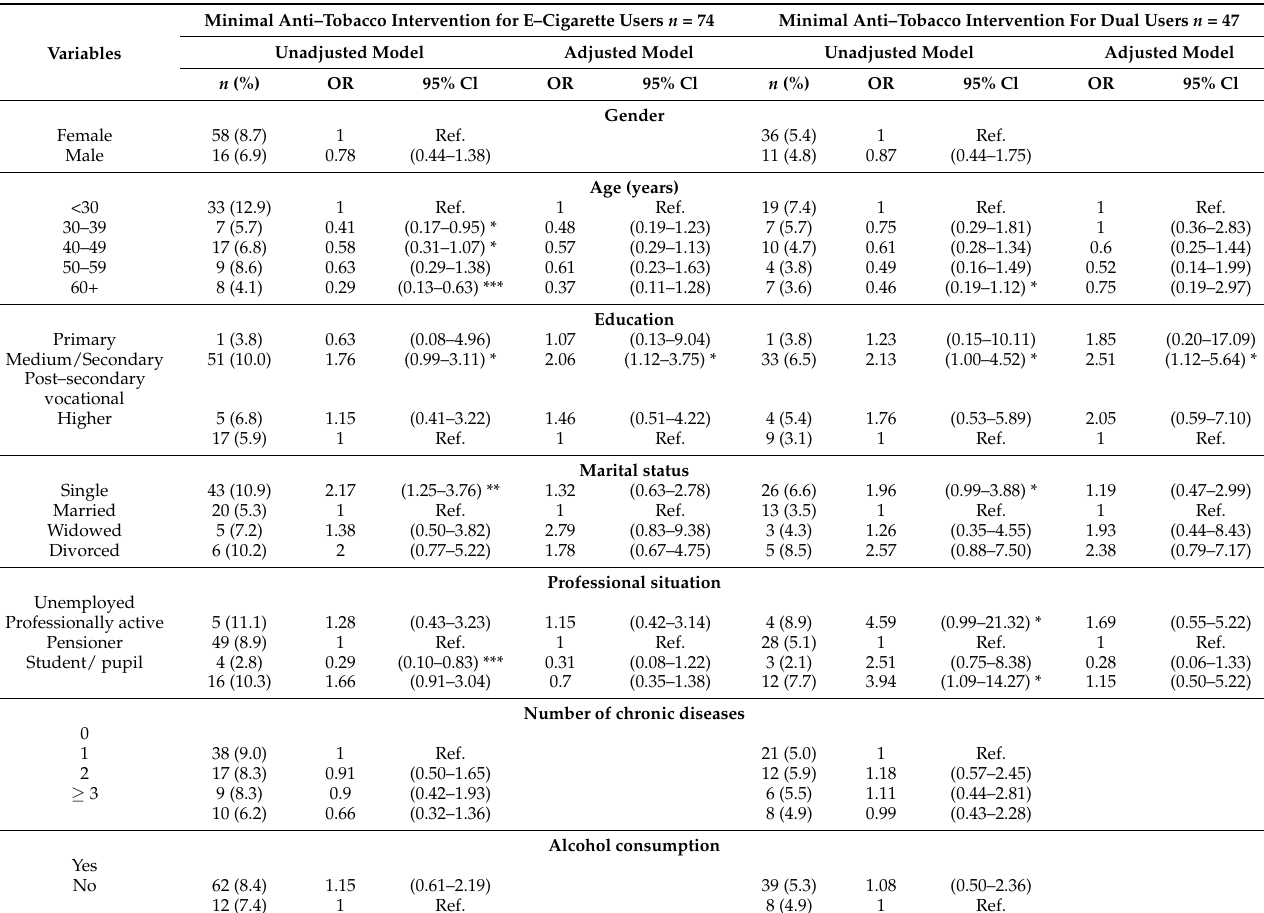
Table 6. The odds ratio of receiving advice from a family doctor according to the analyzed variables (multivariate logistic regression analysis) in e-cigarette users and dual